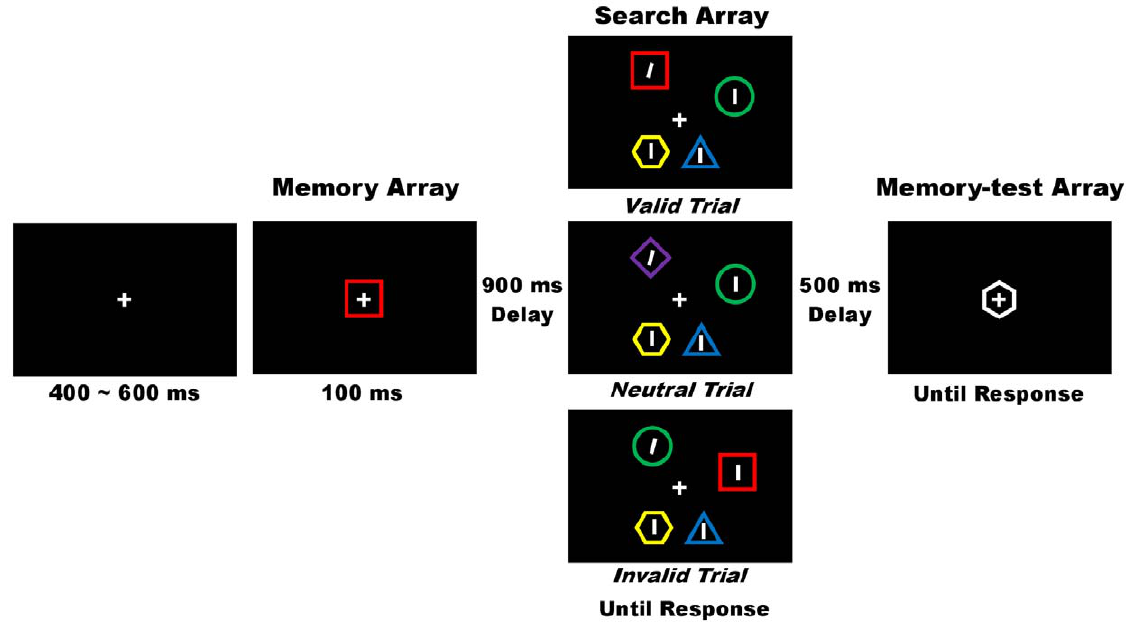
Figure 1. Sequence of the task under low working memory load.